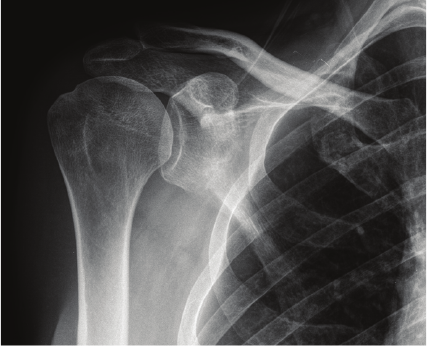
Figure 2: Glenoid neck